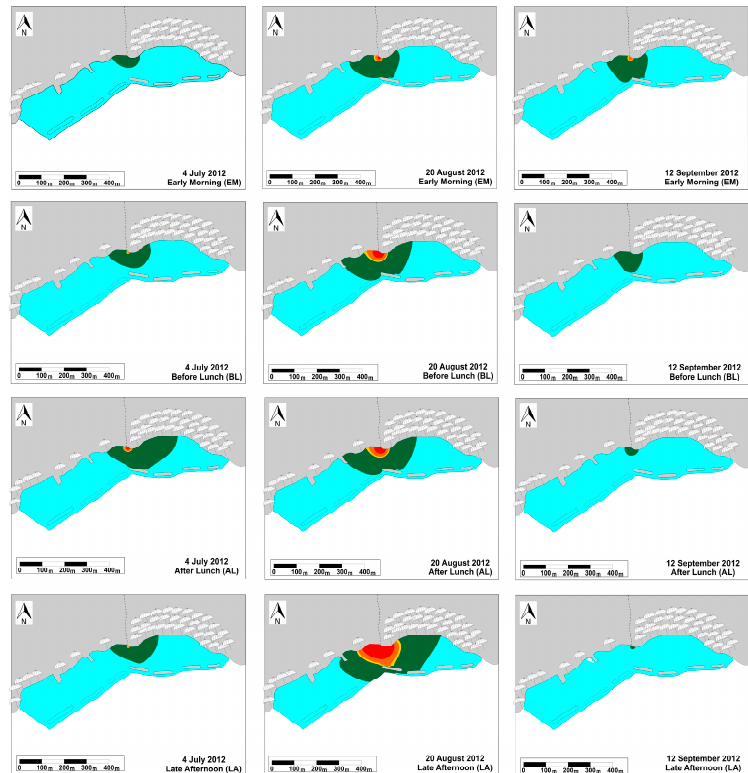
Figure 3. Concentration of living E. coli within the classified survey area according to the water quality criterion reported in the Legislative Decree 116/2008 (red = water banned for bathing use; orange = poor quality; yellow = sufficient quality; green = good quality; light blue = excellent quality). The microbiological water quality within La Perla del Tirreno bathing area was calculated in the three sampling days of summer 2012 (July, August, September, in columns) and the four con- sidered daily periods (in rows).